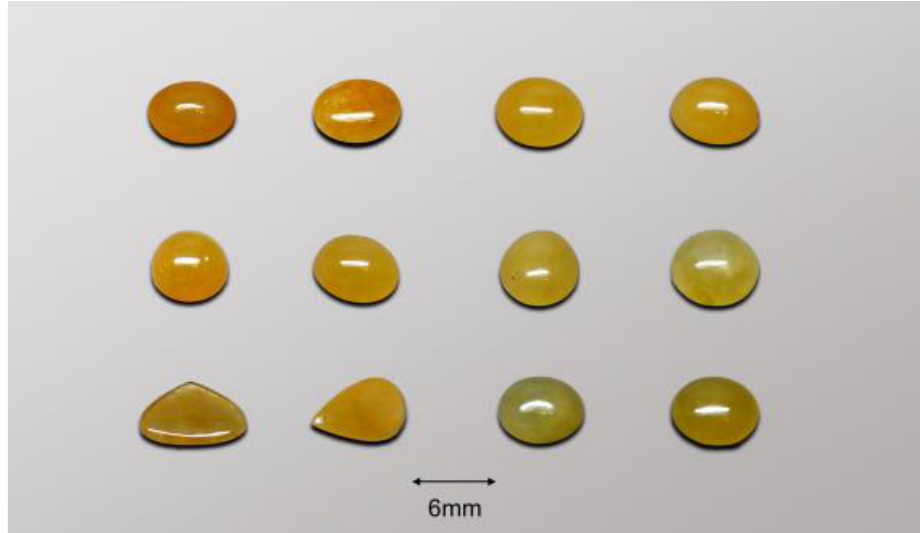
Figure 1. Part of the samples used in this study.